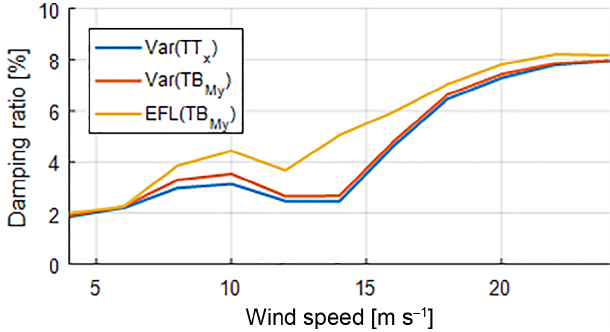
Figure 5. Damping ratios optimized for different output for DC